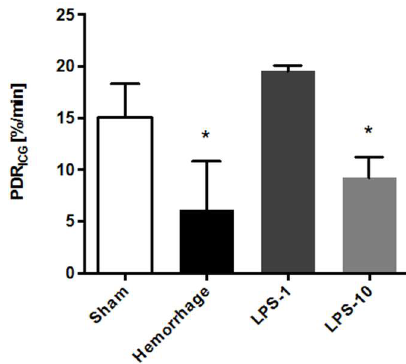
Figure 2. The plasma disappearance rate of indocyanine green (PDR ICG ) was significantly reduced after hemorrhagic shock and severe endotoxemia (LPS-10), compared with the sham-operated controls and moderate endotoxemia (LPS-1). An asterisk (*) indicates p < 0.05 vs. sham and vs. moderate endotoxemia. LPS = lipopolysaccharide.